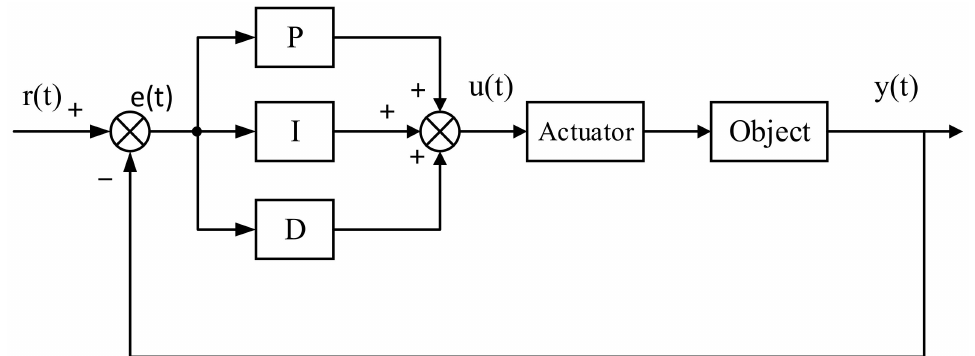
Figure 1. PID control schematic